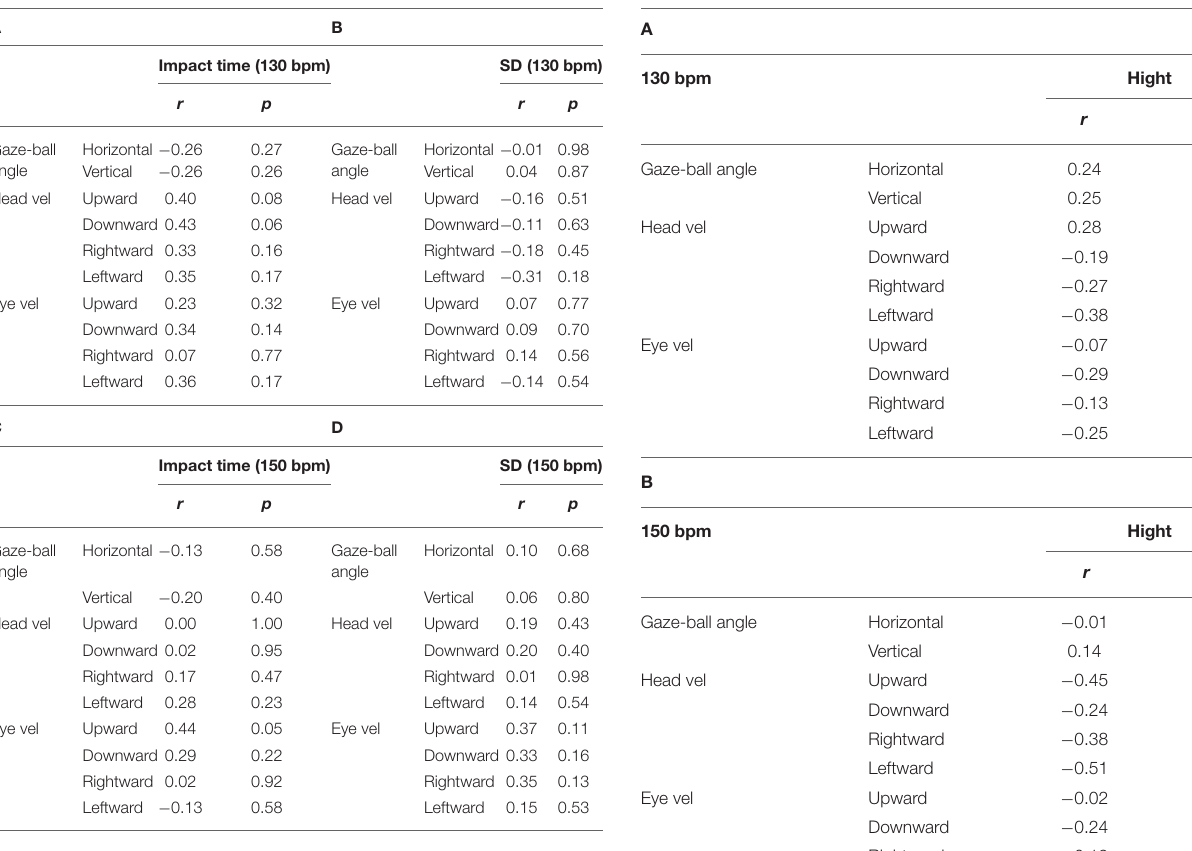
TABLE 3 | Pearson correlation between impact time and the gaze-ball angle, eye velocity, and head velocity in each tempo.